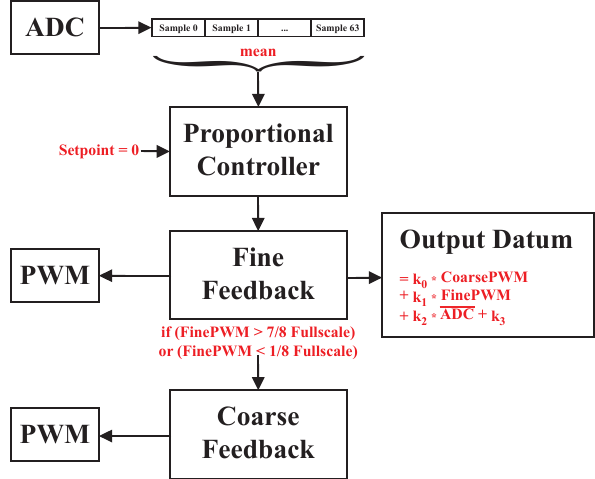
Fig. 4. Block diagram showing major elements of the FPGA logic. Variables k 0 , k 1 , k 2 , and k 3 are experimentally determined scal- ing coefficients for the coarse PWM, fine PWM, ADC, and offset